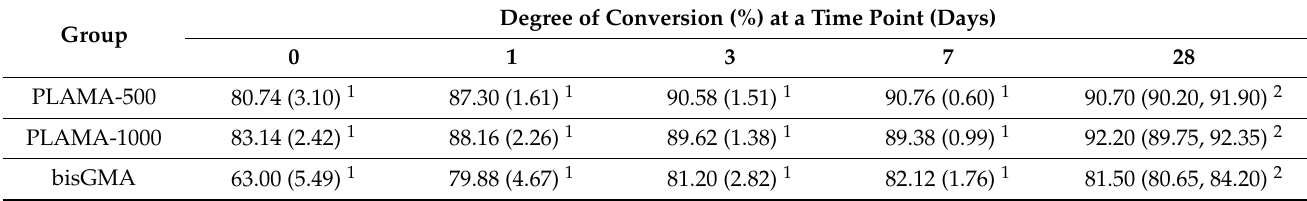
Table 2. Measured degree of conversion of double bonds in cured polymers.